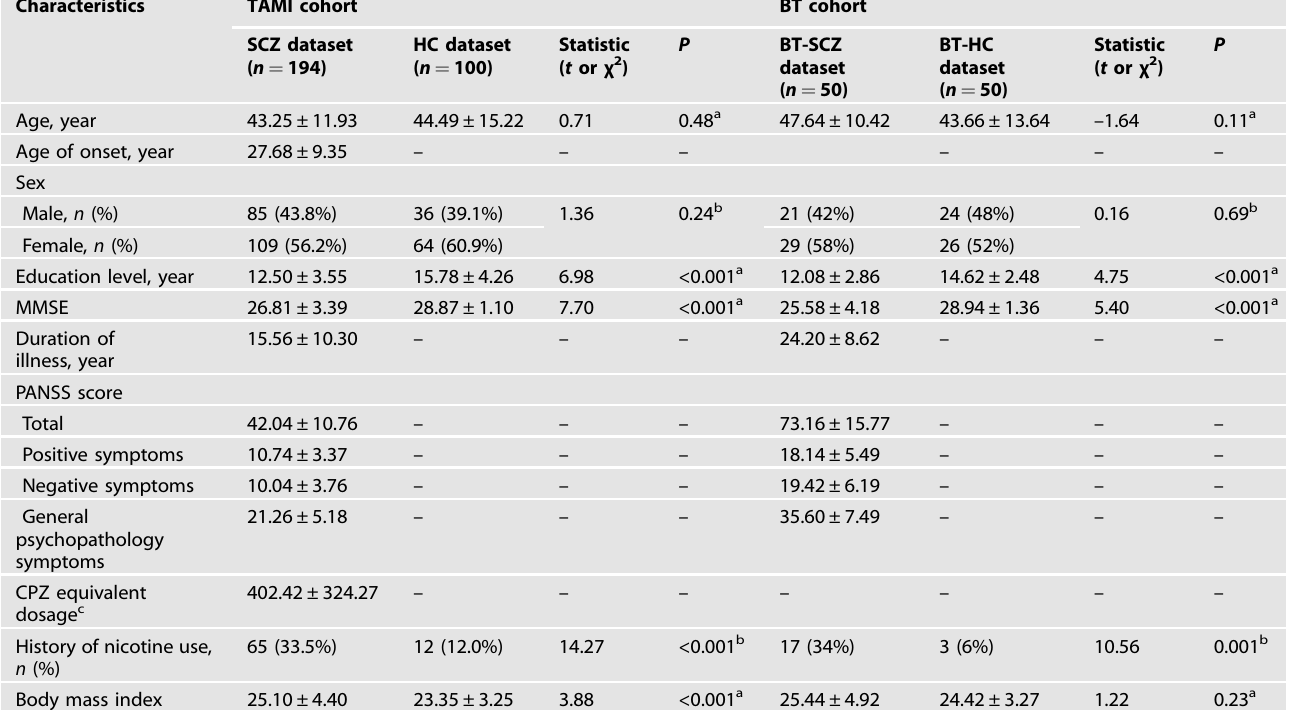
Table 1. Clinicodemographic characteristics of individuals with schizophrenia and HCs in two cohorts.